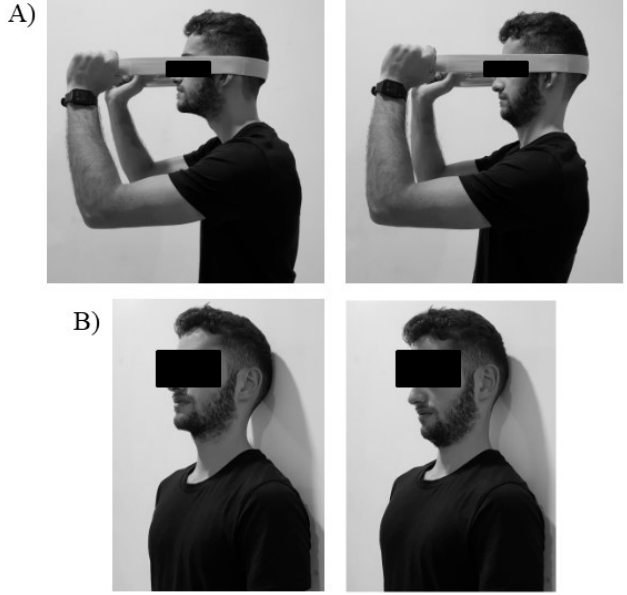
Figure 1. Specific therapeutic neck exercises included in the intervention. ( A ) Flexion-extension resistance exercise. ( B ) Cranio–cervical flexion exercise.